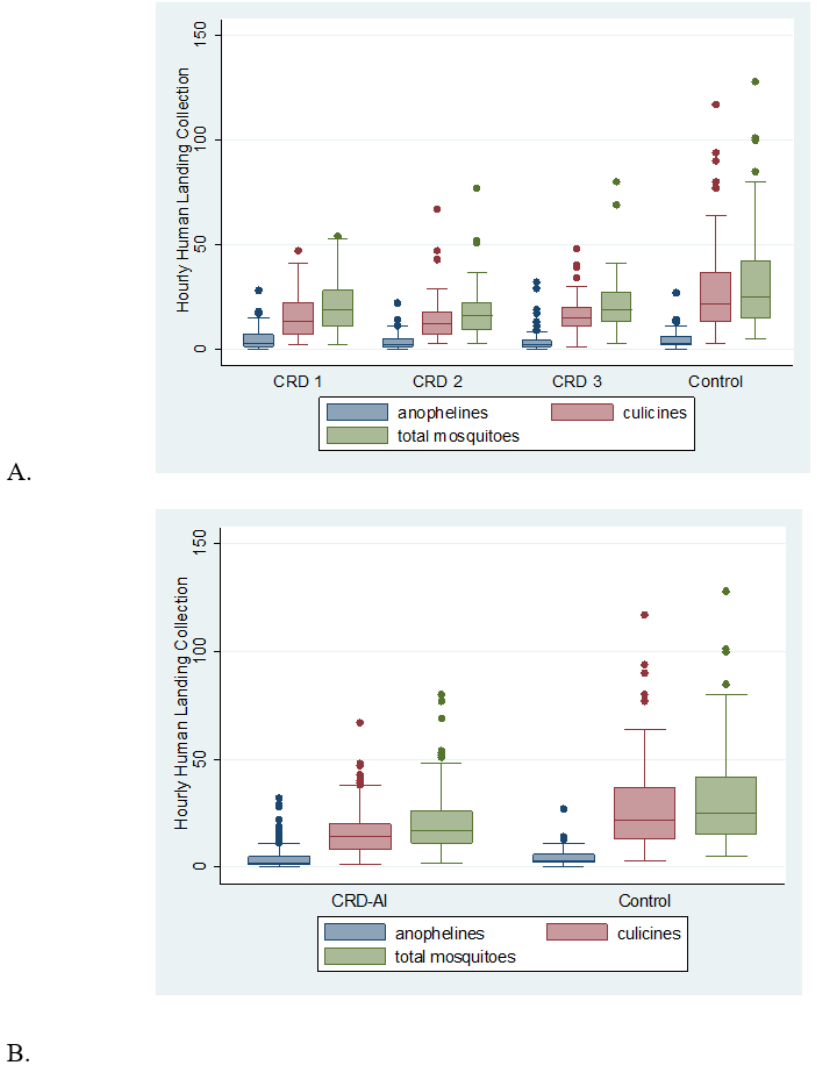
Figure 2. Plots of hourly catches of anophelines, culicines, and total mosquitoes recorded. ( A ) Control and individual CRDs (CRD 1, CRD 2, CRD 3). ( B ) Control CRD versus the mean of number of mosquitoes collected in CRDs with metofluthrin (CRD-AI). Mosquito species were collected using protected human landing collections in Mapacocha, Loreto, Peru, between 10 and 26 January 2017. A further non-parametric two-sample Wilcoxon rank-sum test (Mann – Whitney) was applied to determine if untreated control (CRD-C) and combined data from CRDs 1 – 3 with insecticide (CRD-AI) had an equal impact on the number of mosquitoes caught hourly by protected HLC. In Figure 2B Control and Devices with AI HLCs are shown. Devices with AI had a reductive effect on culicines (CRD-AI = 16.03 vs. CRD-C = 29.2; p < 0.0001), and total mosquitoes (CRD-AI = 19.99 vs. CRD-C = 33.39; p < 0.0001). The higher variation observed in the control may be attributed to mosquito daily and hourly activity as the field study was carried out with wild mosquitoes. Consistent reduction (smaller variations) of HLC in the active group could be observed regardless of test days and hours. One possible explanation of such a reduced dispersion is that the AI inhibited the overall activity in the active group. Fewer Anopheles spp. were collected in the CRD-AI ( p = 0.025 for the one-tailed test), which, although not as strong as in the previous cases, is statistically significant as well.